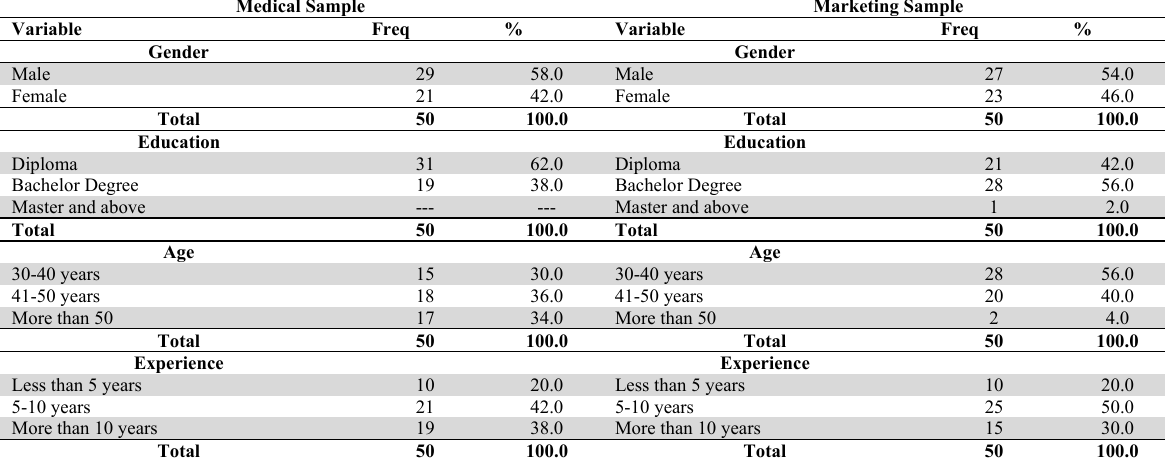
Demographical distribution for the